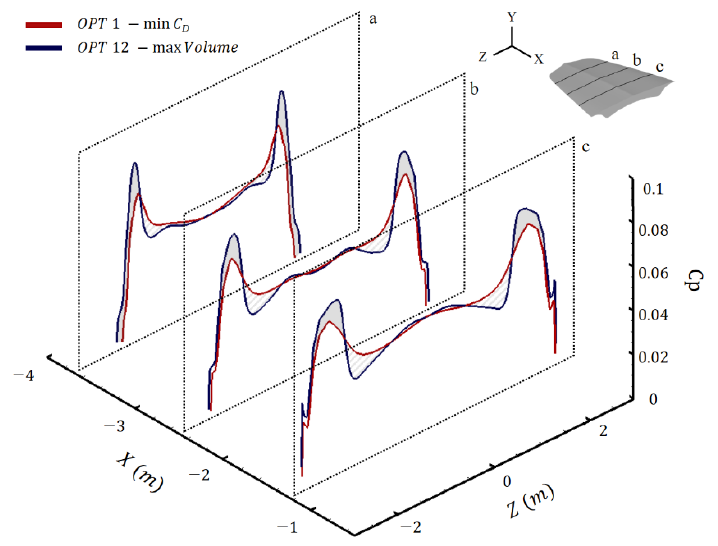
Figure 15. Lower surface pressure coefficient distribution for OPT 1 and OPT 12.